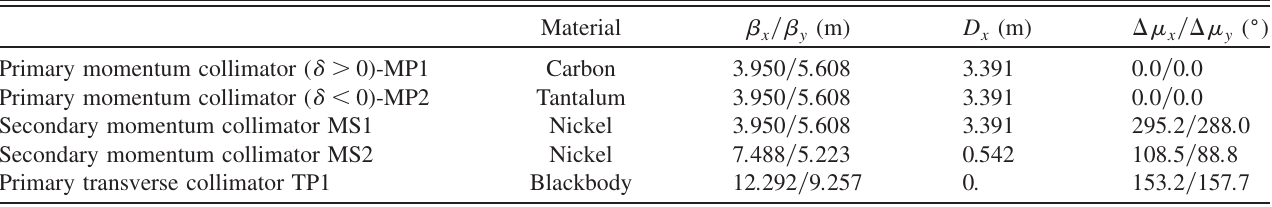
TABLE III. Collimators used for the combined momentum collimation method studies. (Note: The phase advances for MS1 are for the next turn with given tunes of 5 : 82 = 5 : 80 ).